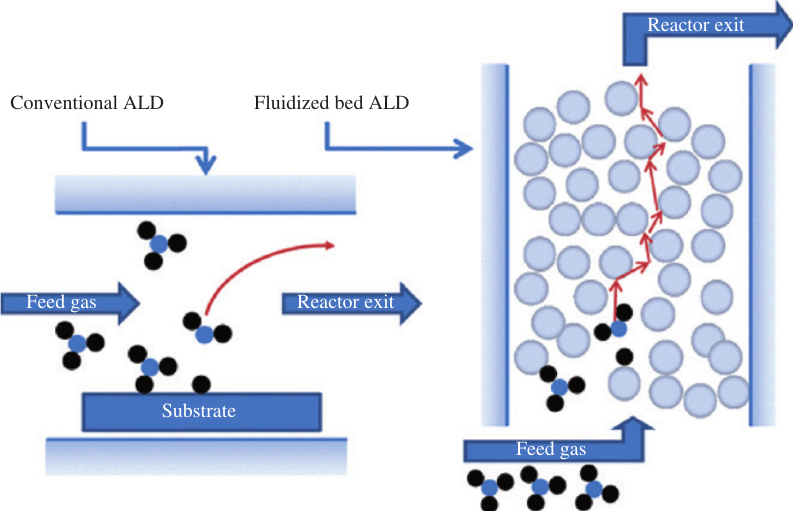
Figure 13: Removal of molecules in a “conventional” ALD reactor with a single substrate and a fluidized bed ALD reactor filled with particles. Reprinted with permission from Ref. [112]. Copyright 2016 Springer.